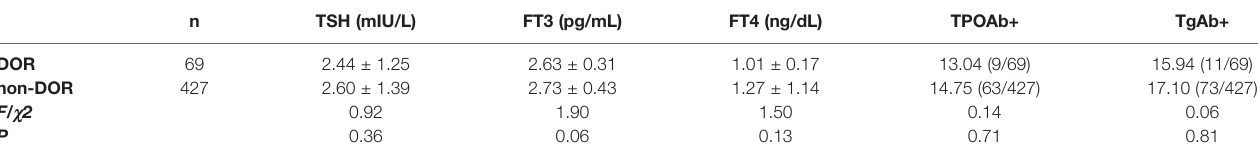
TABLE 8 | Comparison of thyroid hormone between DOR and non-DOR